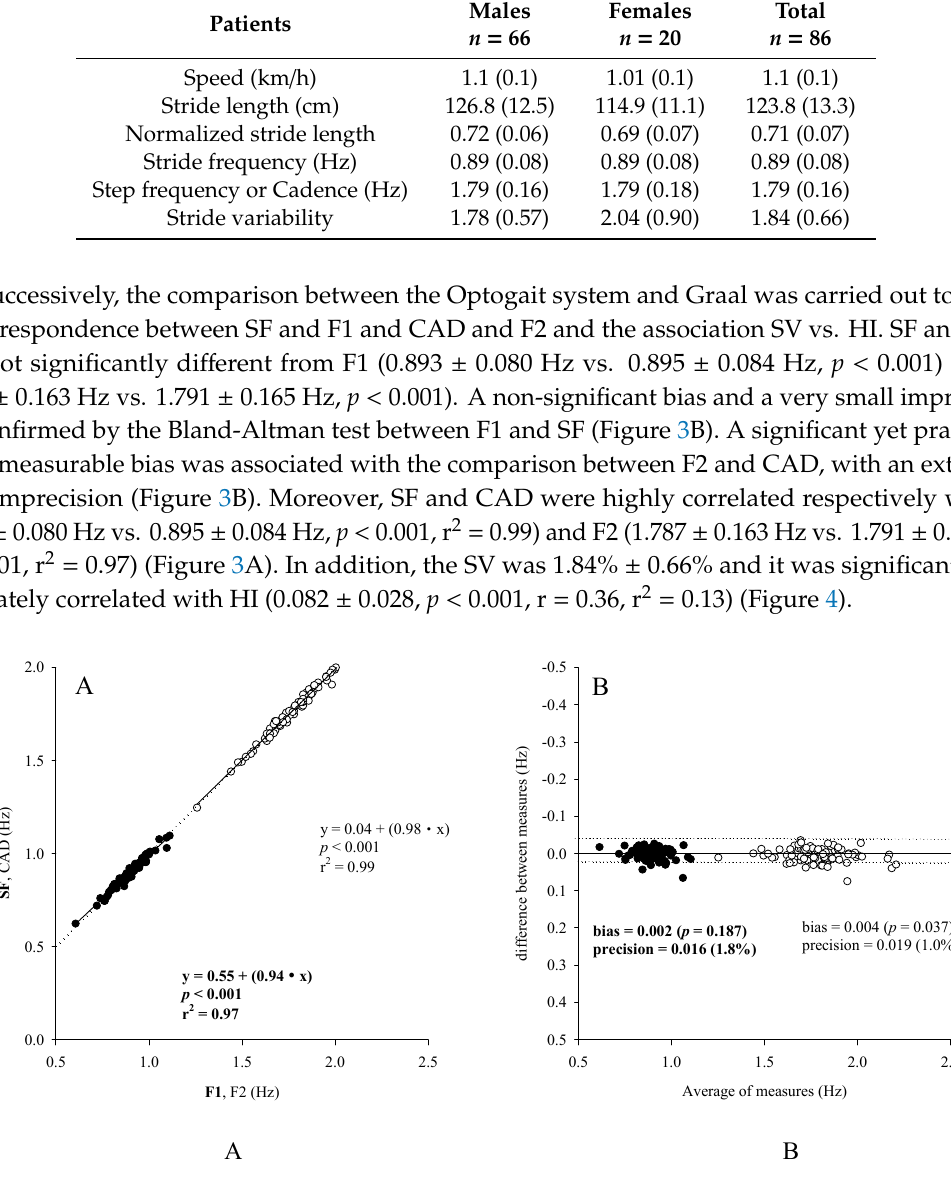
Figure 3. Scatterplots ( A ) and Bland-Altman plots ( B ) of stride frequency (SF) and Cadence (CAD) vs Frequency 1 (F1) and Frequency 2 (F2), measured by Optogait against Graal.